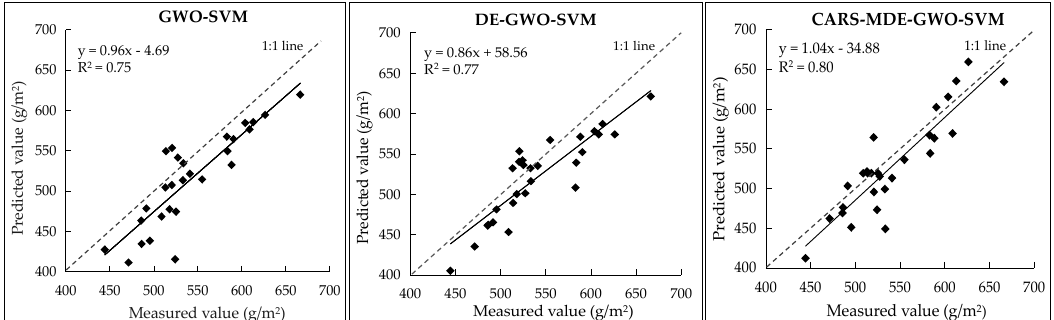
Figure 10. Scatter plots of measured versus predicted above-ground biomass (AGB) obtained by different support vector machine (SVM) models, shown for the sugar growth stage in 2014, as an example. GWO, DE–GWO and MDE–GWO refer to grey wolf optimization algorithm, differential evolution–GWO and modified DE–GWO algorithms, respectively.